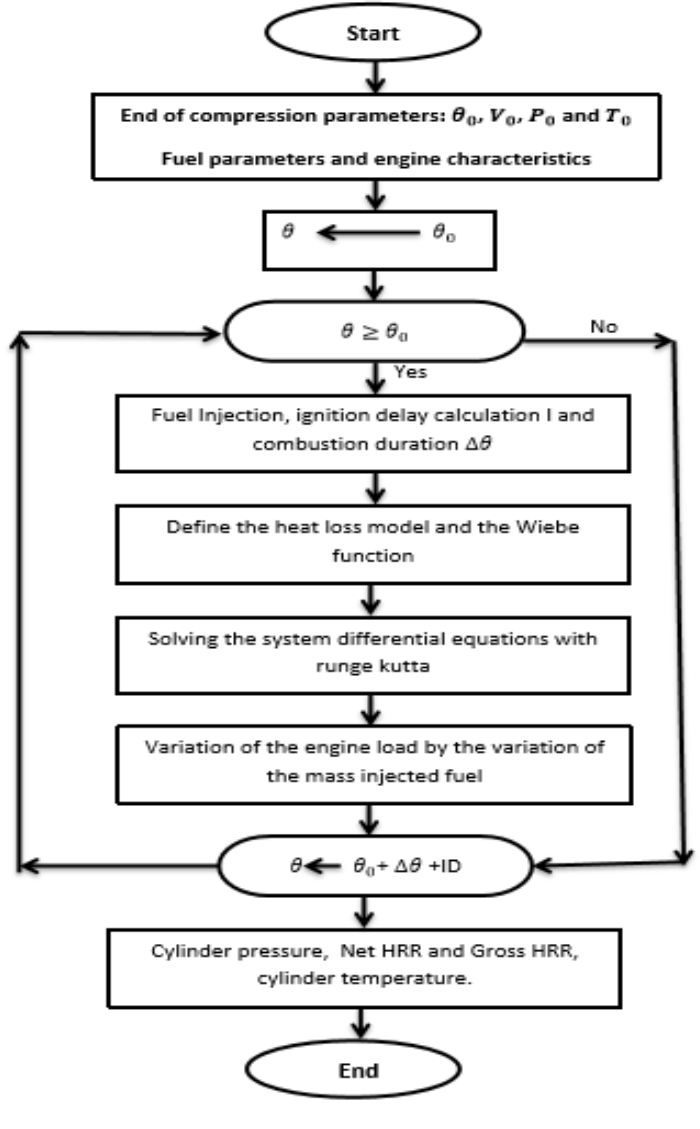
Figure 2. Digital diagram.